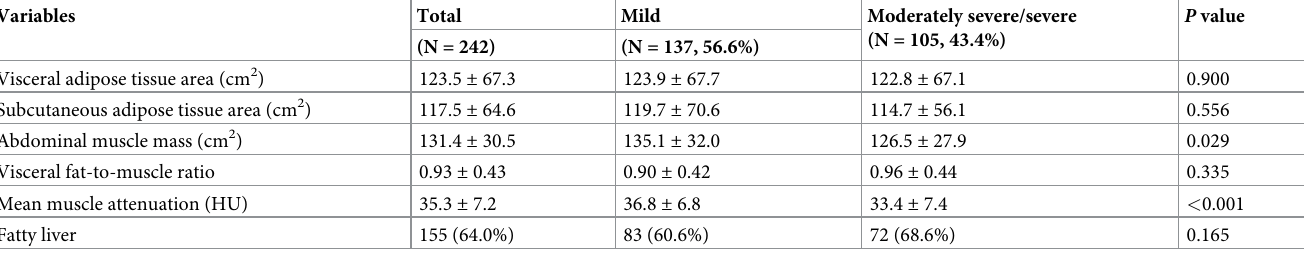
Table 2. Body composition parameters and severities of alcoholic acute pancreatitis.